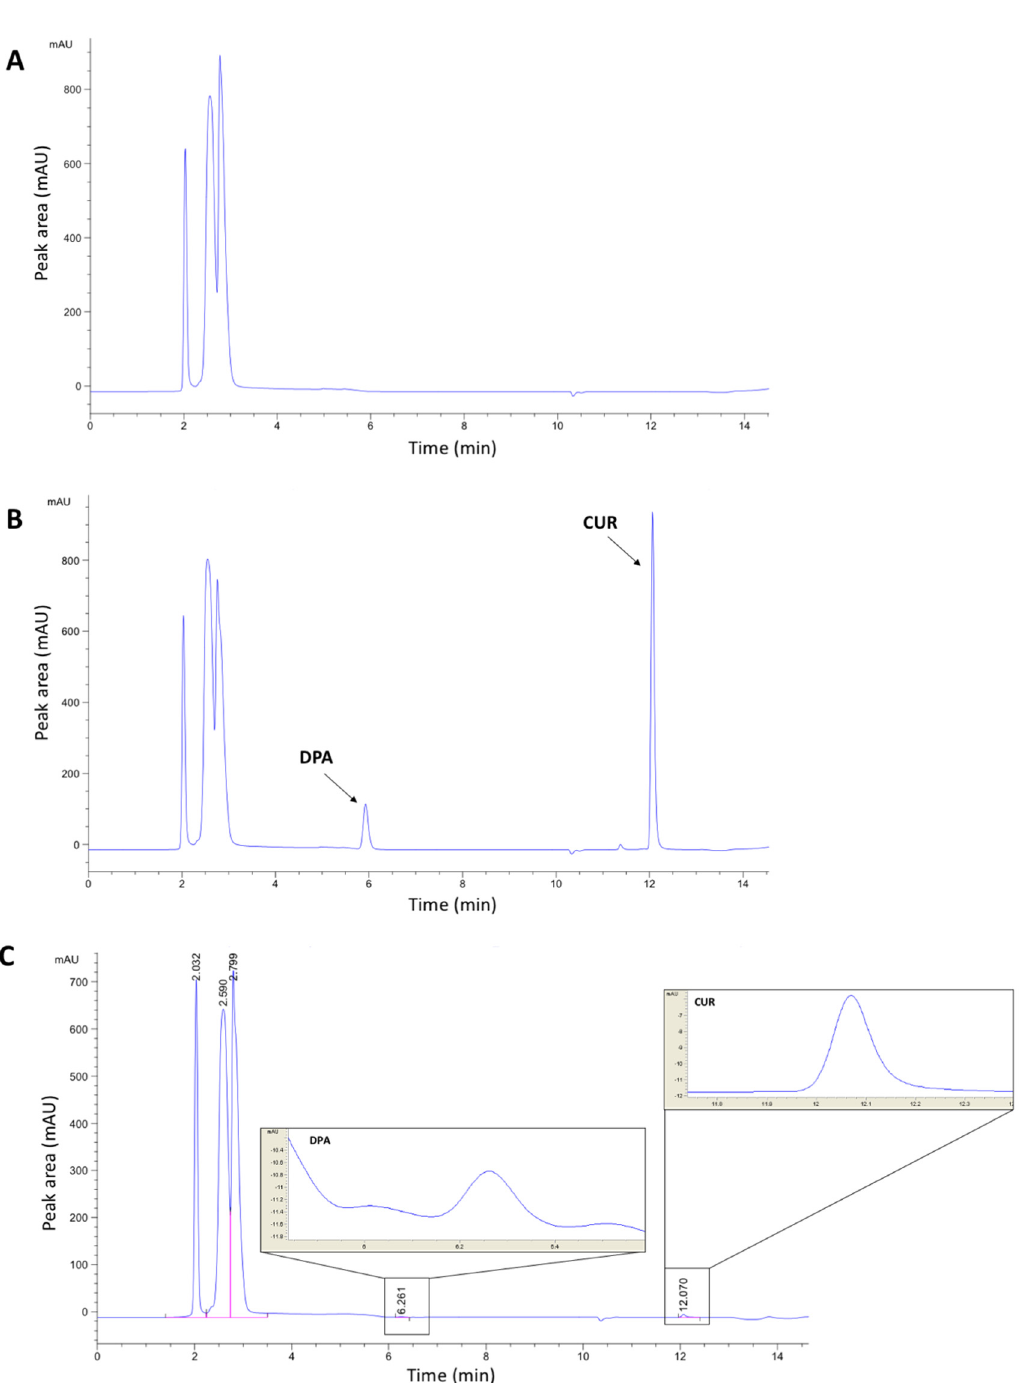
Figure 1. Representative chromatograms of CUR and DPA in release media: ( A ) blank release media (PBS pH 7.4 containing 0.5% w / v Tween ® 80 and 0.1% w / v of ascorbic acid); ( B ) CUR and DPA (12.5 μ g mL − 1 for both drugs) in release media; ( C ) LOD chromatogram (0.019 μ g mL − 1 ).